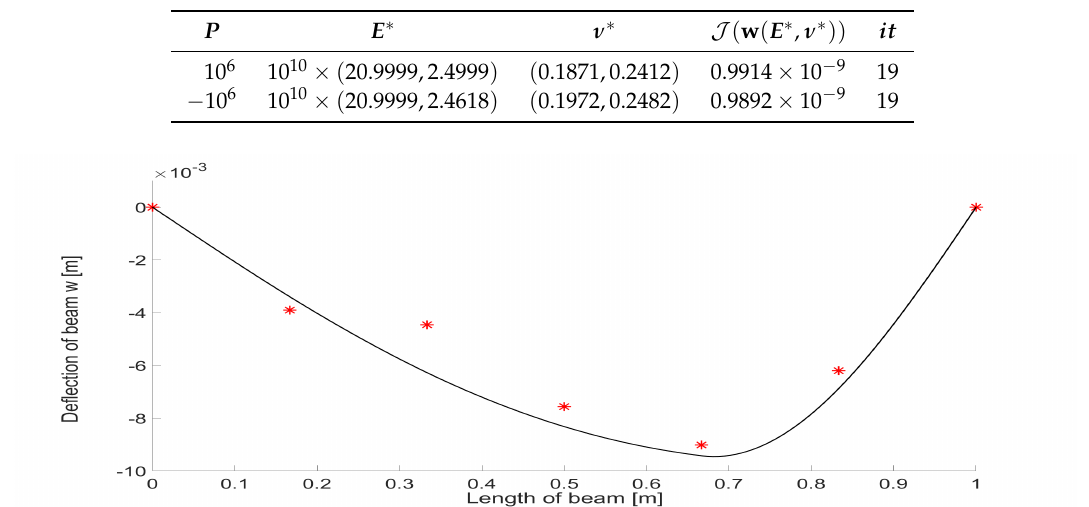
Table 1. Results of presented examples